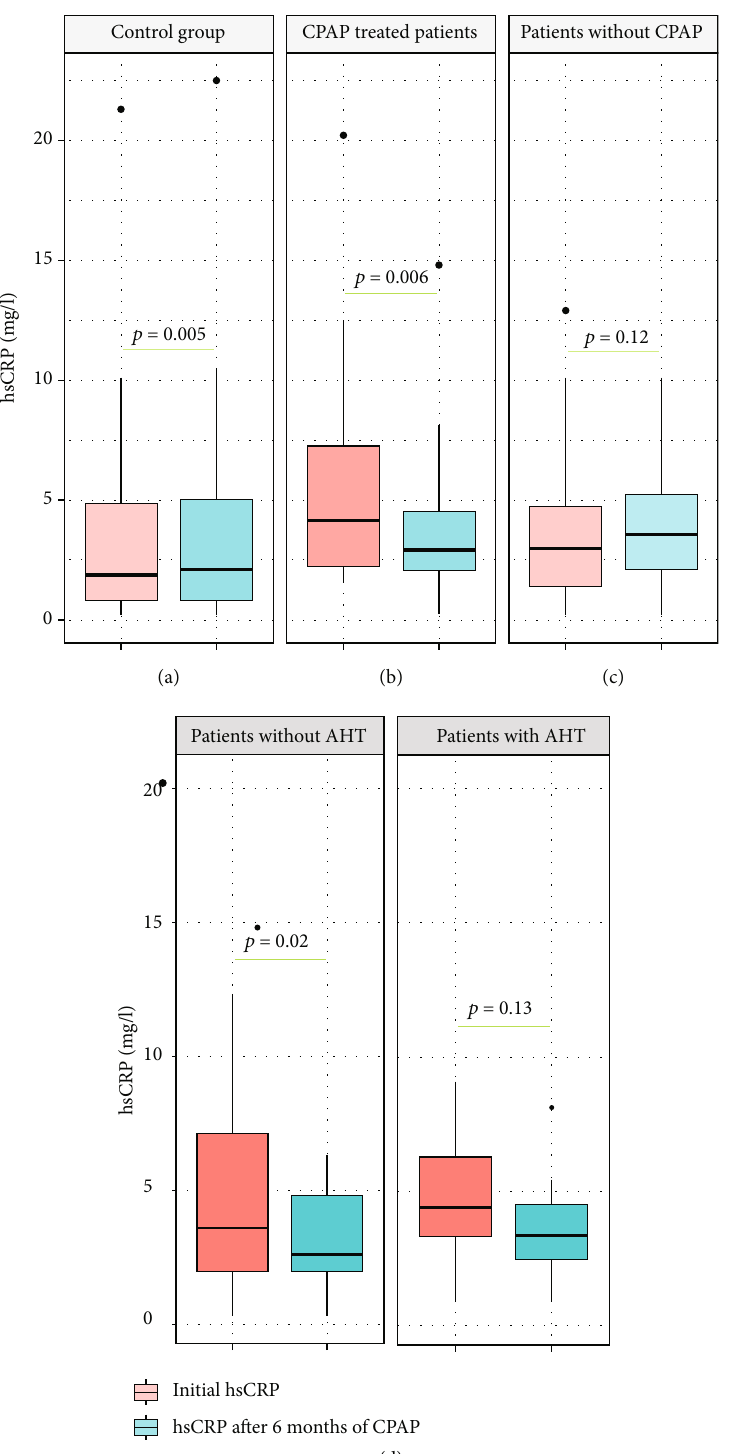
Figure 3: (a – d) E ff ects of 6 months of nCPAP therapy on the plasma hs-CRP levels. nCPAP: nocturnal continuous positive airway pressure. hs-CRP: high-sensitivity C-reactive protein. OSAHS: obstructive sleep apnea-hypopnea syndrome. AHT: arterial